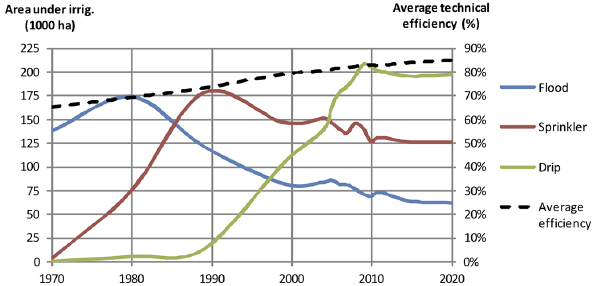
Fig. 6. Change in on-farm irrigation methods and estimated wa- ter use efficiency in the Guadiana Basin, 1970 to 2010. Source: based on statistical data from CHG (2013), INE (2009), and MAGRAMA